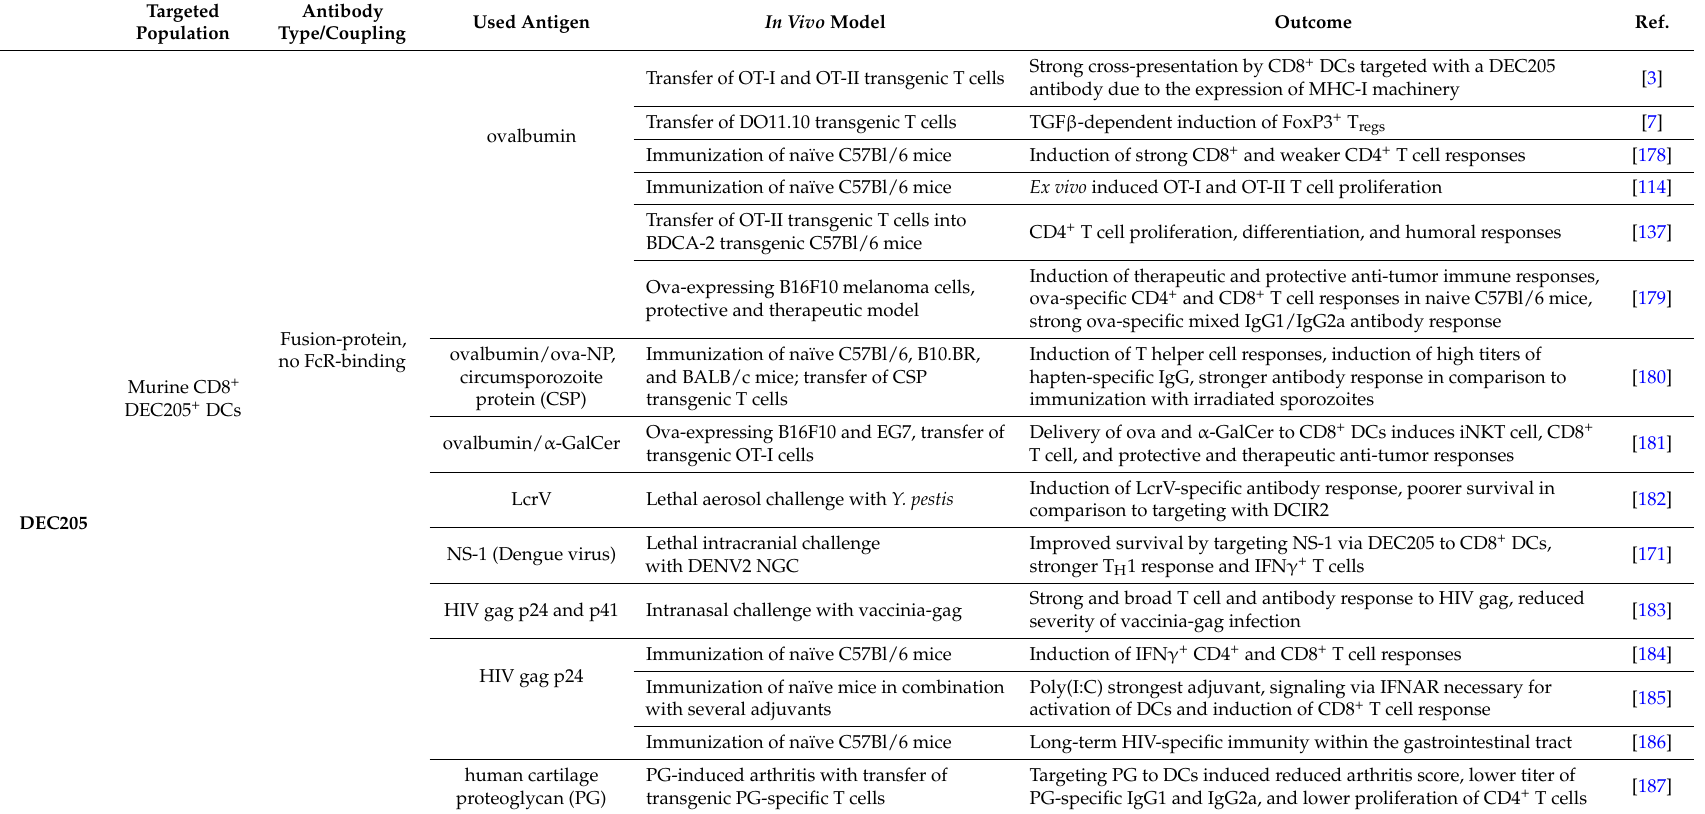
Table 1. Overview of important antigen targeting